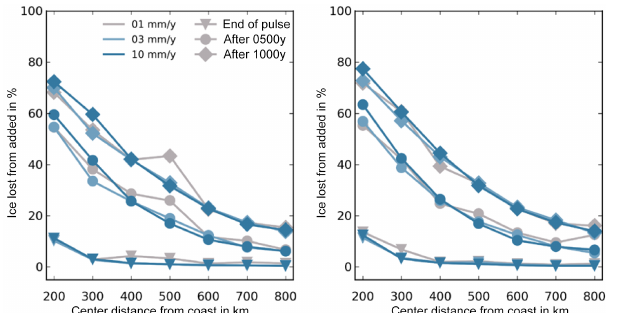
Figure 2. Additional ice discharge compared to mass addition for different distances from the coast. The fraction of the added ice that is lost again to the ocean as a function of distance from the coast at which the additional ice was placed for the simulations without (left panel) and with (right panel) surface warming. Colors indicate the magnitude of the mass addition equivalent to 1, 3, and 10mmyr − 1 sea-level rise mitigation. Markers correspond to the different relax- ation times: end of pulse, 500 years, and 1000 years after the pulse of mass addition